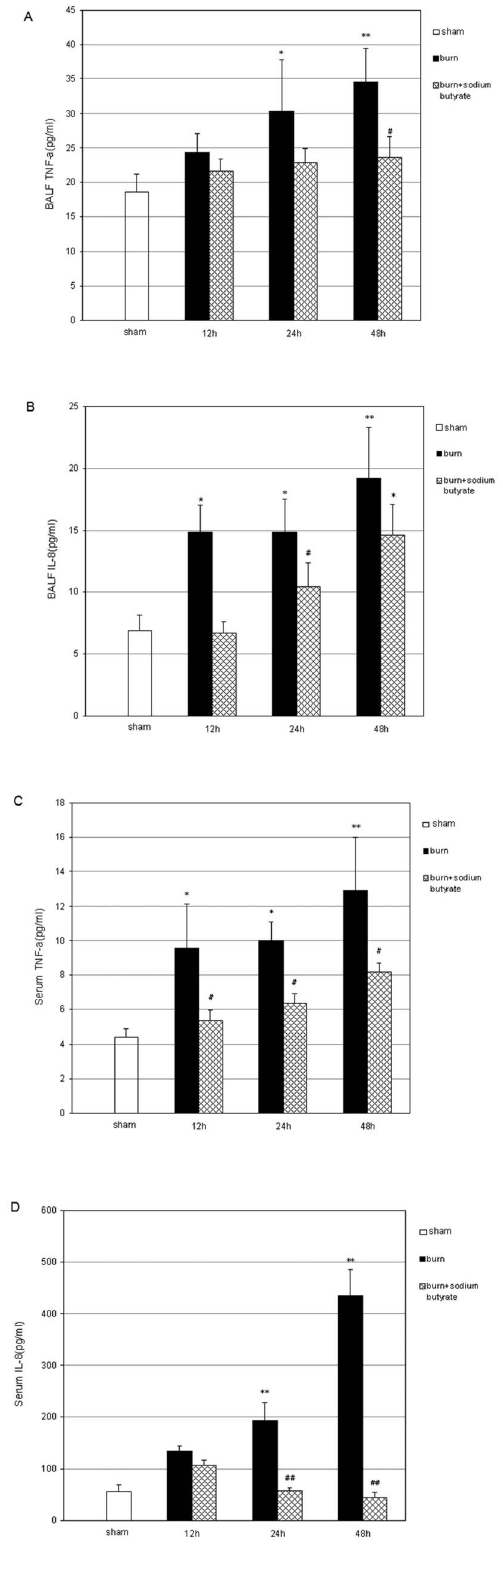
Figure 2. Effect of sodium butyrate on the concentrations of inflammatory mediators in BALF and serum after burn injury. After the 30% TBSA full-thickness burn injury, the TNF- a and IL-8 concentrations were markedly increased in BALF and serum at 12 h post burn and remained in high values up to 48 h. Sodium